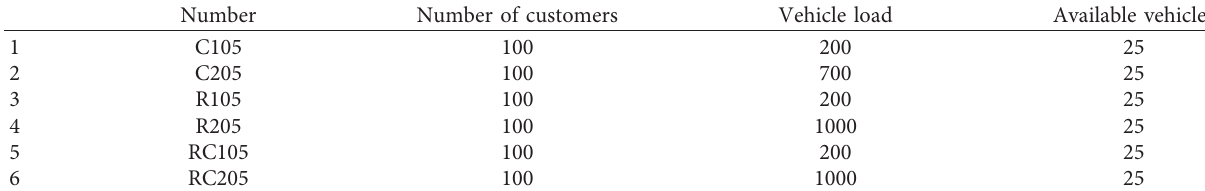
Table 1: The characteristics of the test cases selected in this paper.